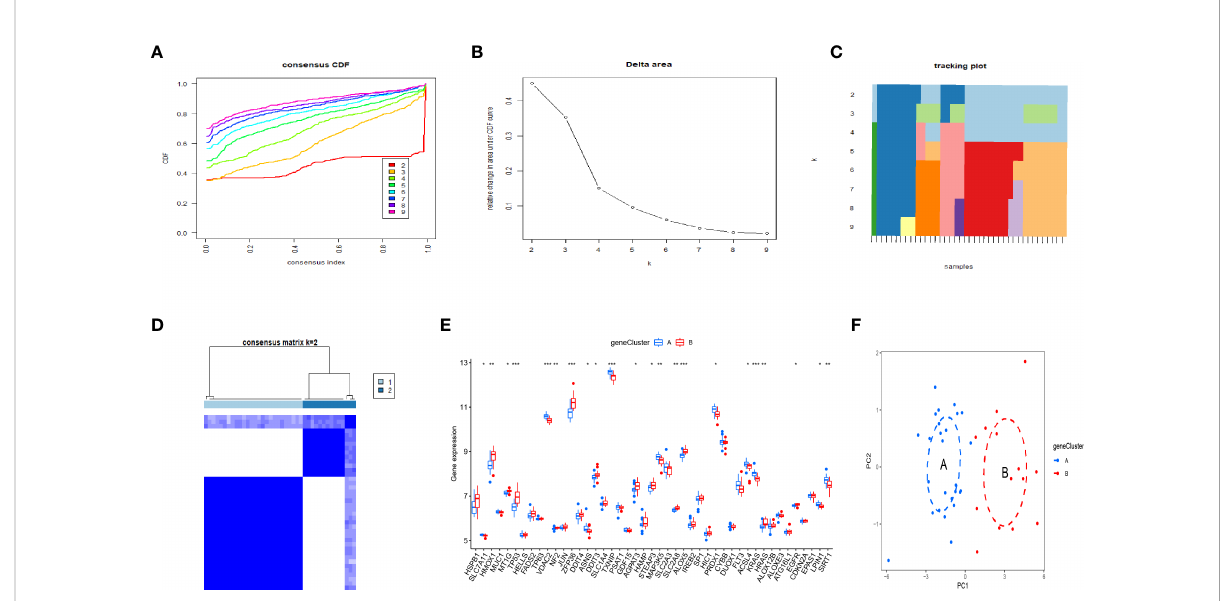
FIGURE 6 Two OP subgroups re-obtained by consensus clustering based on DEGs. (A) Curve of the CDF when k=2-9. (B) The delta area score of the CDF curve when k= 2 – 9. (C) Tracking plot when k =2 – 9. (D) The matrix heat map was neatly categorized when k=2. (E) The expression of 37 DEGs between the genecluster A and genecluster (F) PCA based on the expression of the 37 DEGs can distinguish OP patients in genecluster A and genecluster B. *P < 0.05; **P < 0.01; ***P <